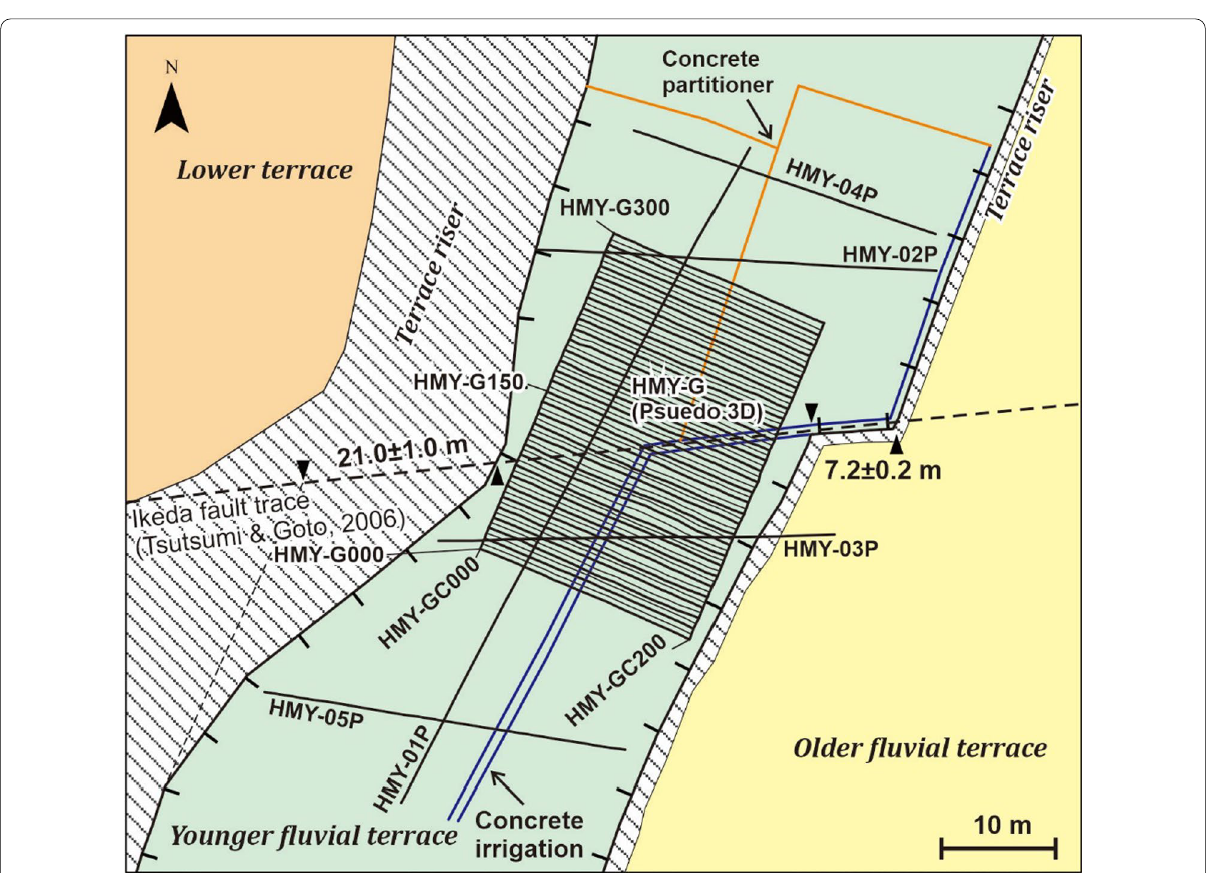
Fig. 2 The survey site map with the 2D and pseudo-3D GPR survey lines. The numbering for the inline sections incrementally increases northward from HMY-G000 to HMY-G300 with a step of 5. The crossline sections consist of HMY-GC000 and HMY-GC200. The Ikeda fault trace, terraces, and two offset terrace risers are from Tsutsumi and Goto